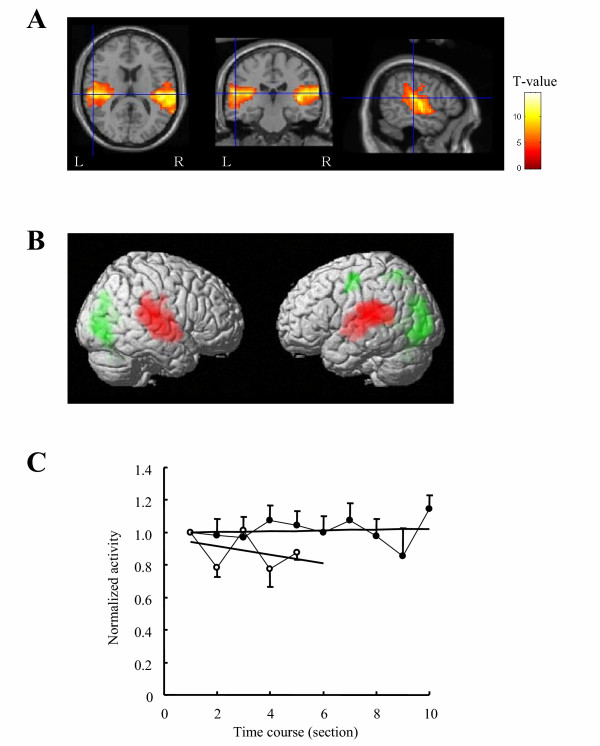
Activity related to transient reduction of fMRI acquisition noise. (A) Statistical parametric maps activated by noise reduction in the pre-fatigue session (random-effect analysis, P < 0.05, corrected). Anatomical locations were mapped on template brains. Axial (left), coronal (middle), and sagittal (left) sections passing through auditory cortices are shown. Crossing line indicates the local activity maximum of the brain regions. The right (R) and left (L) sides are indicated. (B) Statistical parametric maps activated by fMRI noise reduction (red) and visual search (green) in the pre-fatigue session (random effect analysis, P < 0.05, corrected). Combined statistical parametric maps were superimposed on surface-rendered high-resolution MRIs viewed from right and left. (C) Time course of normalised activity in the auditory cortices during fatigue-inducing period in the normal and CFS patient groups. To evaluate the time course of the auditory responses, we divided the fatigue-inducing period into 6-min sections, and measured activity of the brain regions that had been activated by transient reduction of fMRI noise in the pre-fatigue session. Magnitude of the activity was calculated as the peak signal change (%) averaged across the activated areas. Normalised activity was calculated as activity in a given section divided by that in the first section. Data are mean and SEM. Closed circles, normal subjects; open circles, CFS subjects.